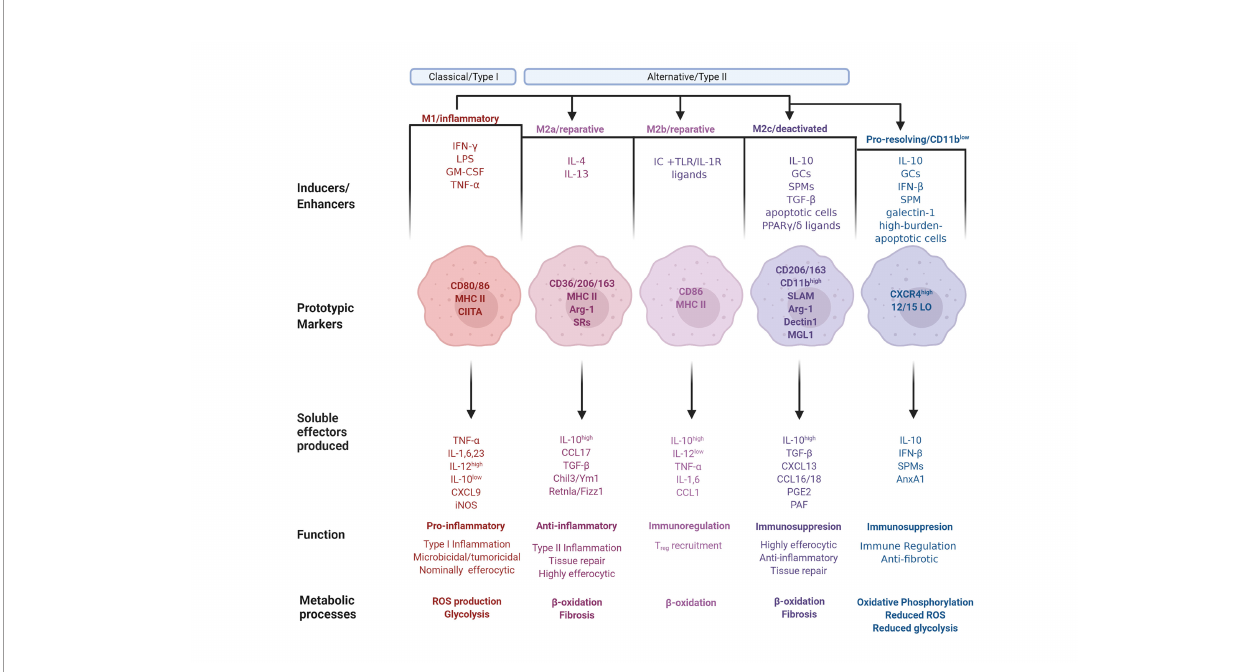
FIGURE 1 | The phenotype continuum of monocyte-derived macrophages. Monocytes migrate into in fl amed tissues and differentiate into macrophages that undergo polarization and acquire distinct functional properties in response to environmental signals. Classically activated or type I macrophages (M1) are polarized and generated after exposure to GM-CSF or IFN- g along with microbial components, such as LPS, or TNF- a . M1-polarized macrophages express the prototypic markers CD80 and CD86, as well as MHC II along with its transactivator, CIITA. M1 macrophages produce pro-in fl ammatory mediators, including TNF- a , Interleukins (IL) 1, IL-6, and IL-23, as well as CXCL9. The macrophage phenotype dichotomy is underscored by their iNOS/arginase 1 and IL-12/IL-10 balance. Consequently, M1 express high levels of iNOS and IL-12 and low levels of arginase (Arg) 1 and IL-10. M1 polarization results in Type I in fl ammation, characterized by heightened microbicidal and tumoricidal activities, which are associated with a low efferocytic rate, ROS production and glycolysis. Conversely, alternatively activated or type II macrophages (M2 phenotype) are generally associated with immunoregulatory and tumor-promoting functions. M2 polarization is subdivided into M2a, M2b, and M2c with nuanced immunoregulatory characteristics. The M2a polarization is induced by IL-4 and IL-13, and characterized by expressesion of CD36, CD206 and CD163, MHC II, Arg-1 and scavenger receptors (SR). M2a macrophages produce anti-in fl ammatory mediators, including high amounts of IL-10, CCL17, TGF- b , Chil3/Ym1 and Retnla/Fizz1. M2a polarization results in Type II in fl ammation and tissue repair, and is associated with b -oxidation, a high efferocytic rate, and fi brosis. Immune complexes in concert with TLR or IL-1R agonist induce M2b polarization with the markers CD86 and MHC II. M2b macrophages produce immunoregulatory mediators, including IL-1 and IL-6, high amounts of IL-10, and low amounts of IL-12, TNF- a and CCL1. M2b macrophages are involved in the recruitment of T reg cells and undergo b -oxidation. The M2c polarization is induced by IL-10, glucocorticoids (GCs), specialized pro-resolving lipid mediators (SPMs), TGF- b , apoptotic cells or PPAR g / d ligands, leading to deactivation programs. M2c macrophage markers are CD206, CD163 and high levels of CD11b, as well as SLAM, Arg-1, dectin1 and macrophage galactose-type lectin (MGL) 1. M2c macrophages produce immunoregulatory mediators, including high levels of IL-10, TGF- b , CXCL13, CCL16 and 18, PGE 2 and platelet activating factor (PAF). M2c macrophages exhibit high efferocytic and anti-in fl ammatory activities and are involved in tissue repair and fi brosis and undergo b -oxidation. Pro-resolving macrophages are a population, which while displaying M1 or M2 properties underwent an additional phenotype conversion to the CD11b low phenotype. This polarization is induced by exposure to IL-10, GCs, IFN- b , SPMs, galectin-1, or uptake of high-burden apoptotic cells. Pro-resolving macrophages express high levels of CXCR4 and 12/15-lipoxygenase (LO) and release IL-10, IFN- b , SPMs and AnxA1. This macrophage subset